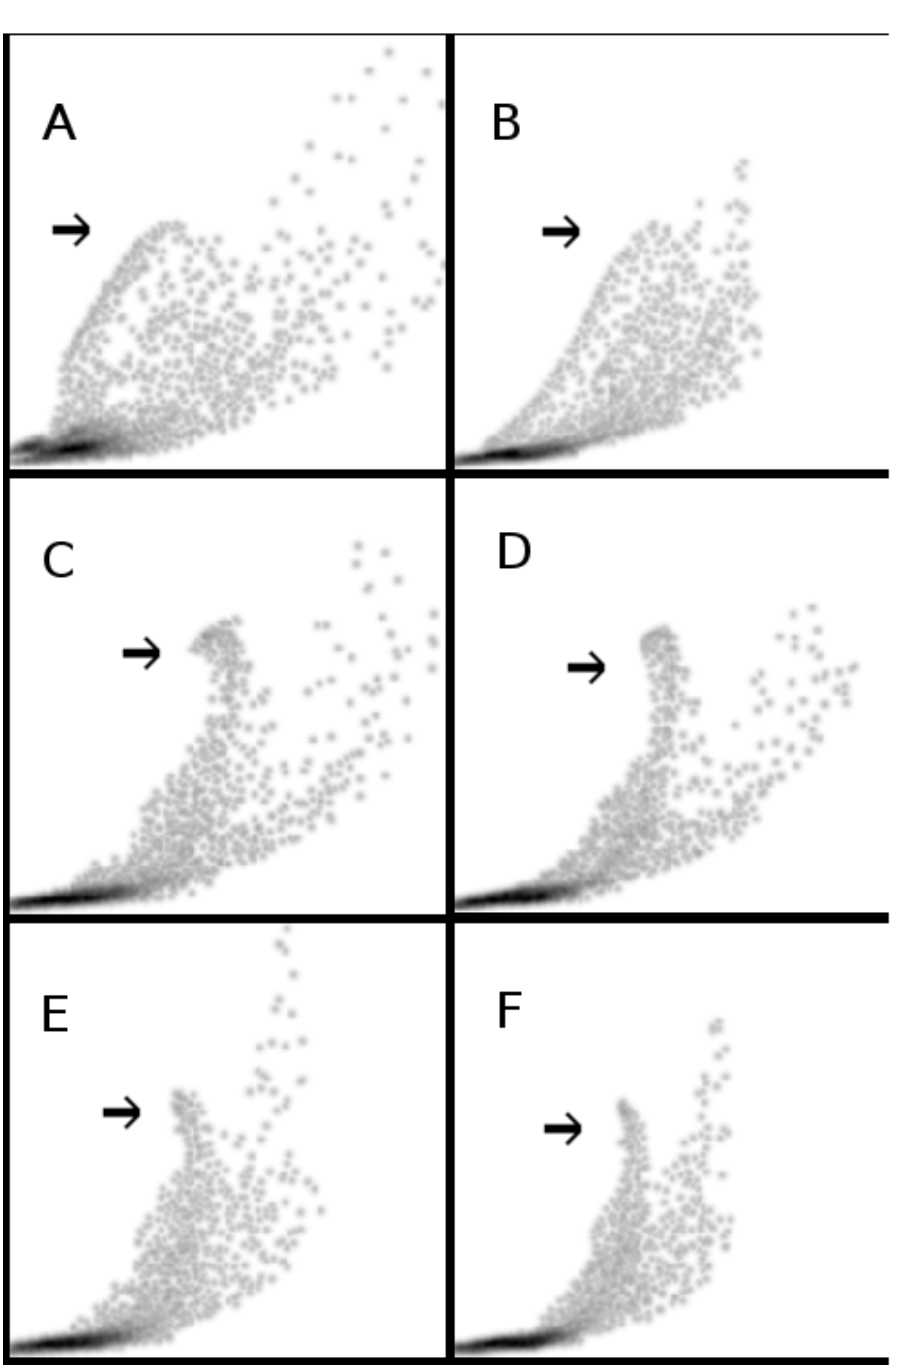
Fig 4. Scatter plots of S 0 against ADC with and without motion correction. Healthy liver DW-MR image data (v3-0528-slc24); scatter plot of S 0 signal against ADC for the identical selected 2D ROI (shown in Fig 2D); a pointer in each plot highlights an example cluster which corresponds to the bright region representing the gallbladder (as shown in Fig 3) for the study of qualitative clustering of pixels; protocol A (A) and NRA method (B); simple averaging (C) and the corresponding blurred version (D); LRA method (E) and the corresponding blurred version (F).